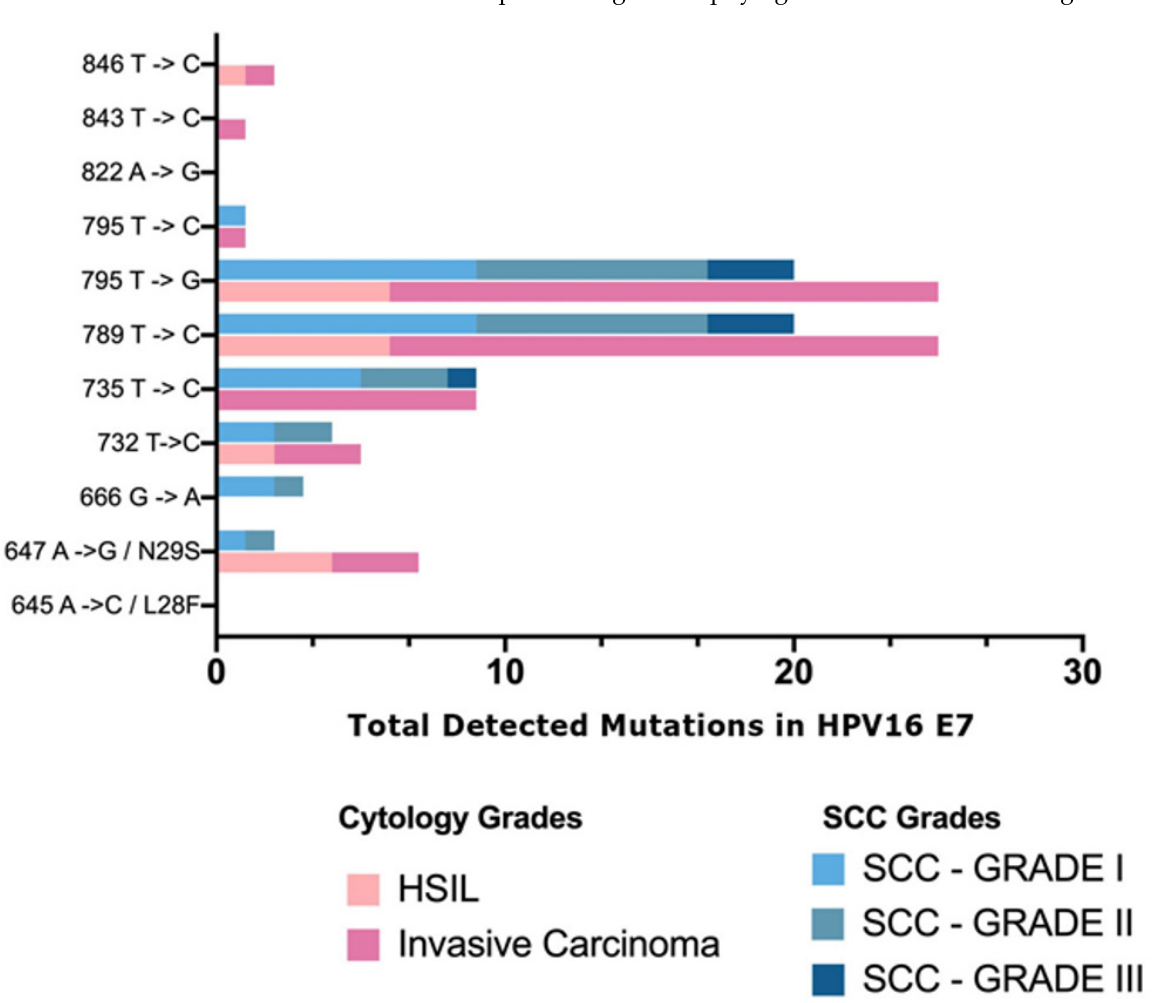
Figure 4. HPV18 phylogenetic tree. Maximum likelihood analysis of the E6 nucleotide sequence. Numbers on the nodes indicate bootstrap values. HSIL represents high-grade squamous intraepithe- lial lesion; SCC, squamous cell carcinoma.